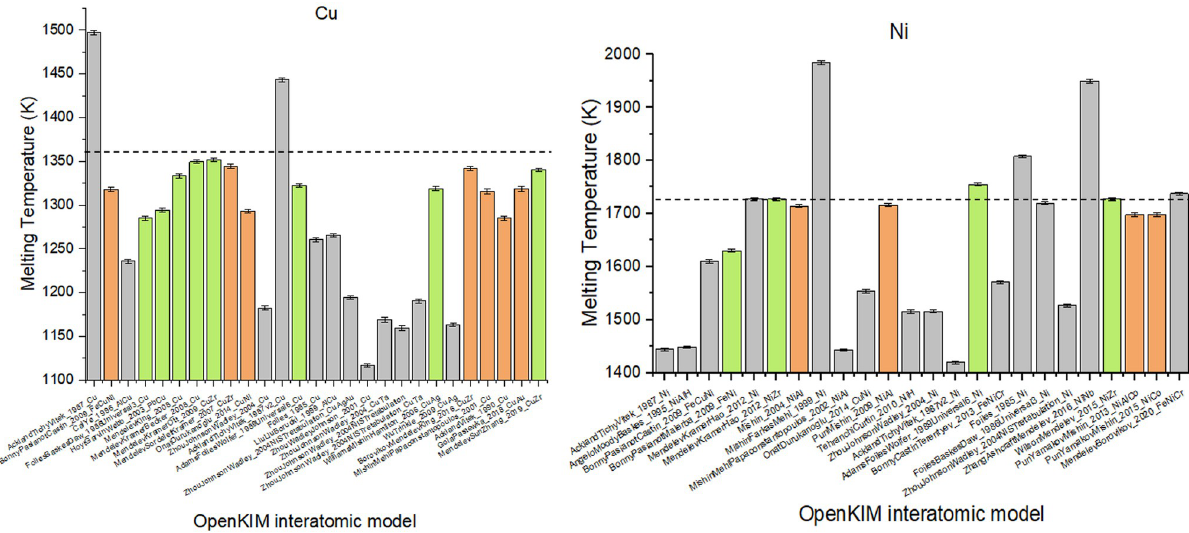
Fig 4. Melting temperature for copper and nickel, using all OpenKIM interatomic models (bars) compared to experimental results (dashed lines). Green bars represent calculations which achieved coexistence and steady state, orange bars are calculations which achieved coexistence but not steady state, indicating that longer run times can successfully determine the melting temperature. Gray bars are calculations that did not result in coexistence.